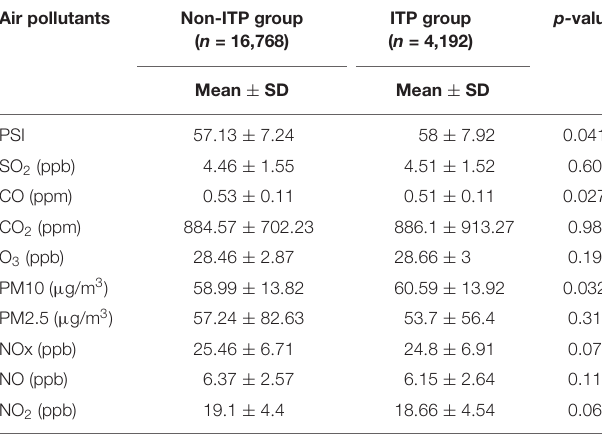
TABLE 1 | Baseline characteristics of ITP and control groups. TABLE 2 | Prenatal exposure to air pollutants in ITP group and